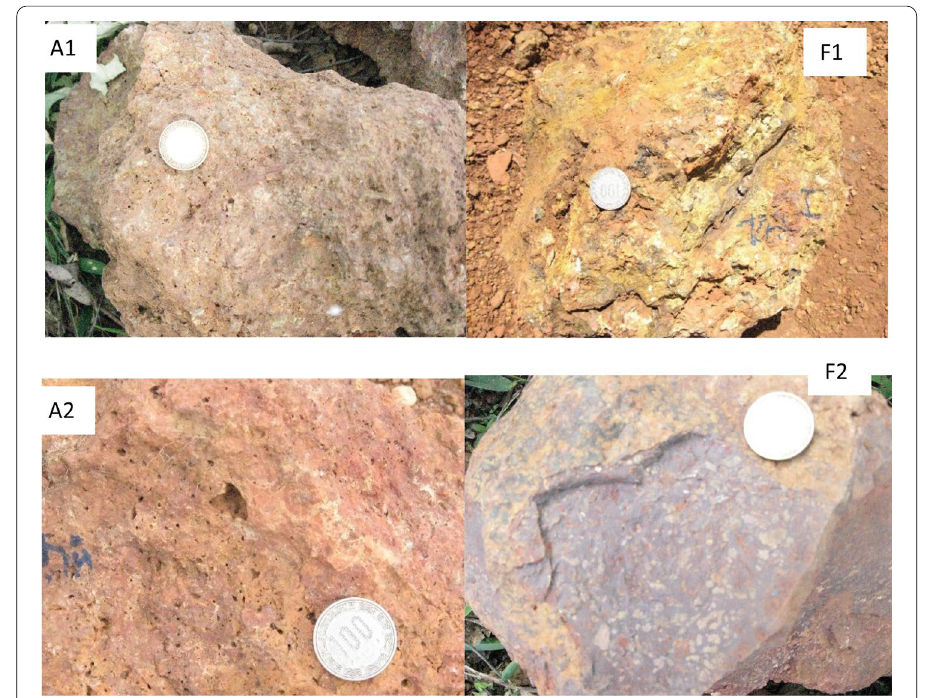
Fig. 3 Samples of lateritic hardpans from the various quarries